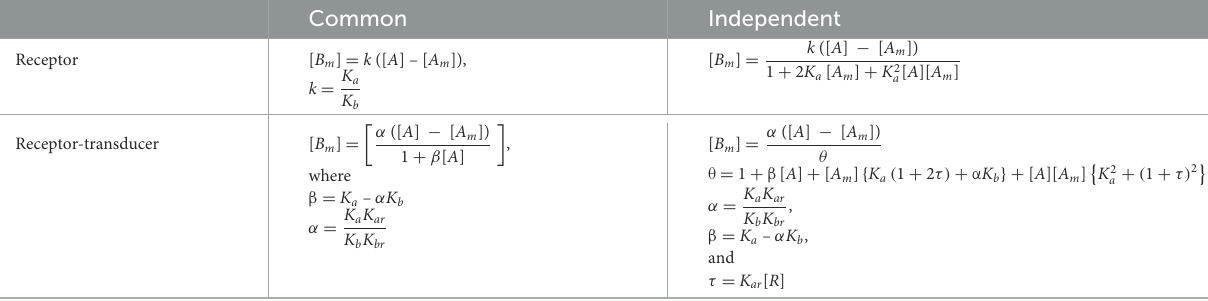
TABLE 1 Receptor and receptor-transducer models assuming common and independent systems. Common Independent